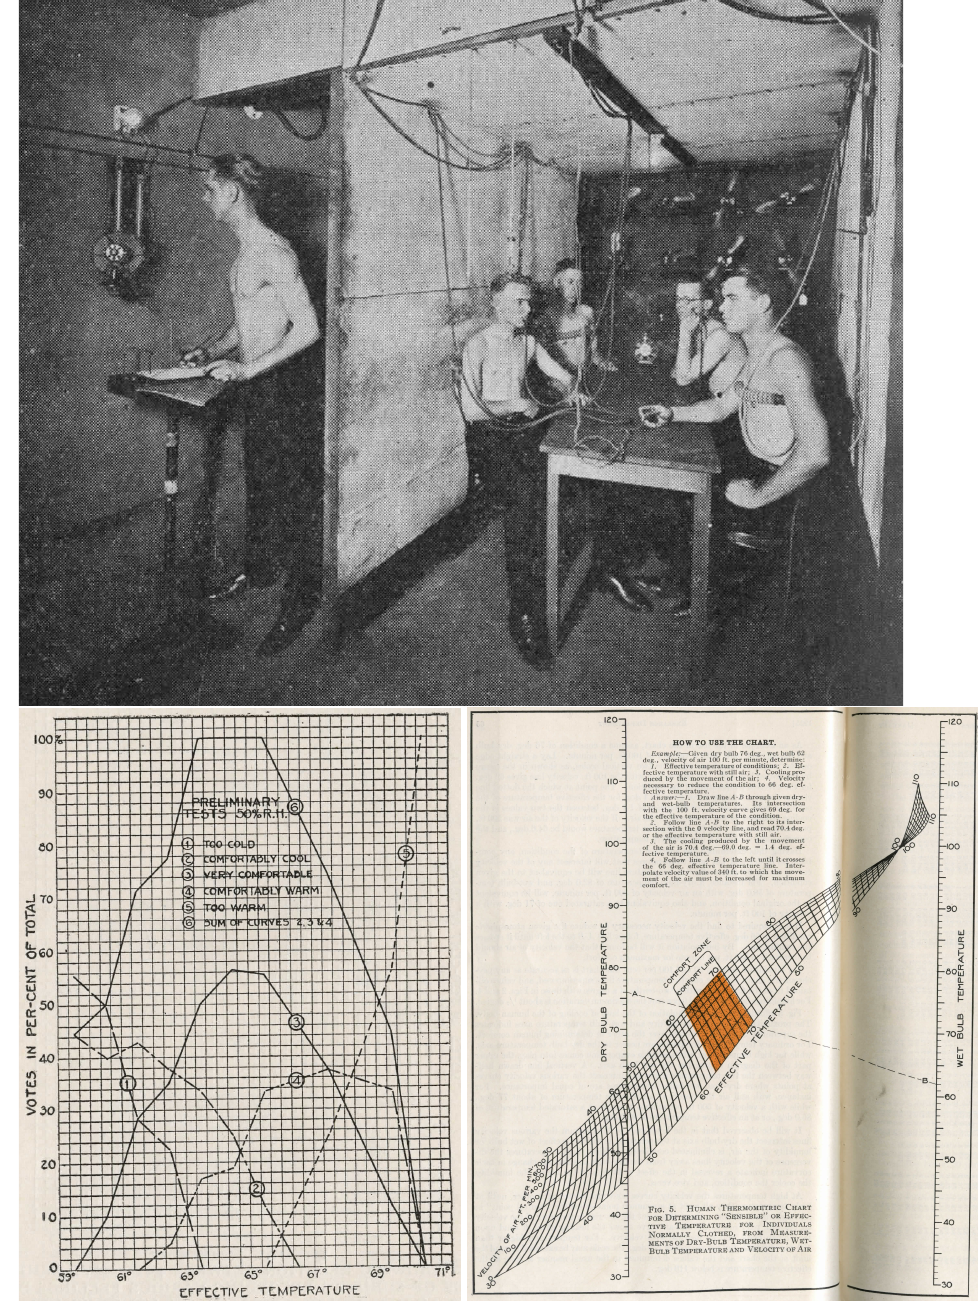
Figure 3. Experimental setup, data, and output of a study determining the comfort zone with air velocity introduced as an independent variable